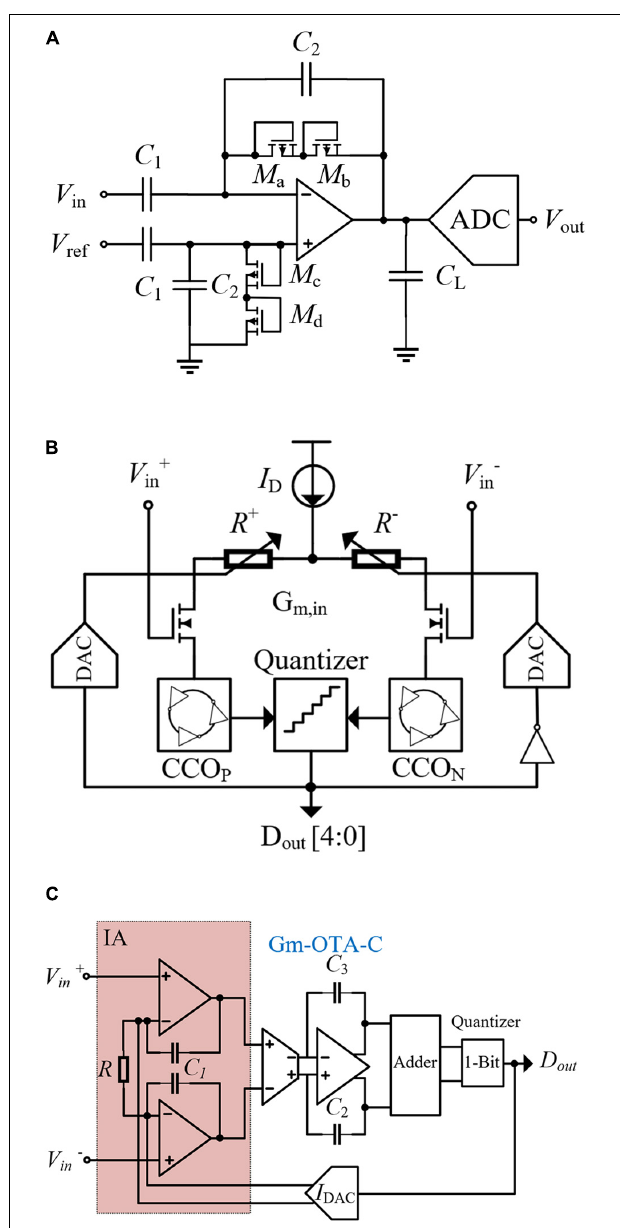
FIGURE 3 | (A) Traditional structure of the neural recorder. (B) Structure of the VCO-based neural recorder. (C) Structure of the neural recording circuit based on